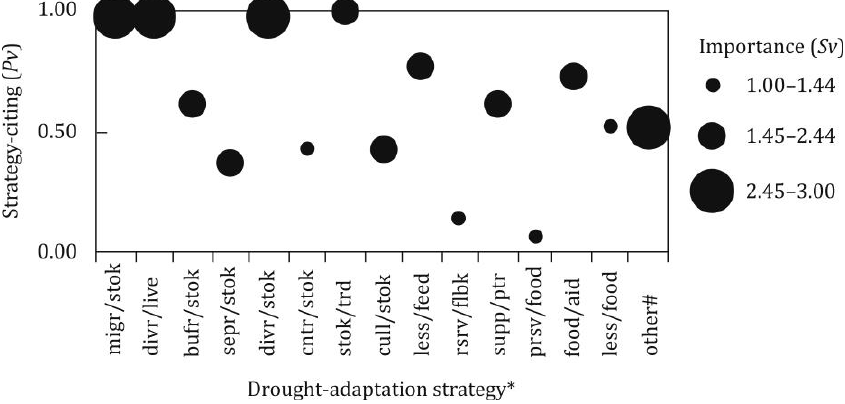
Fig. 2. Drought-adaptation strategies presently utilized in the system of Maasai-pastoralism in the savanna rangelands of Kenya, East Africa Sv = Scaled-importance value, migr/stok = migrate-livestock, divr/liv = diversify-livelihood, bufr/stok =